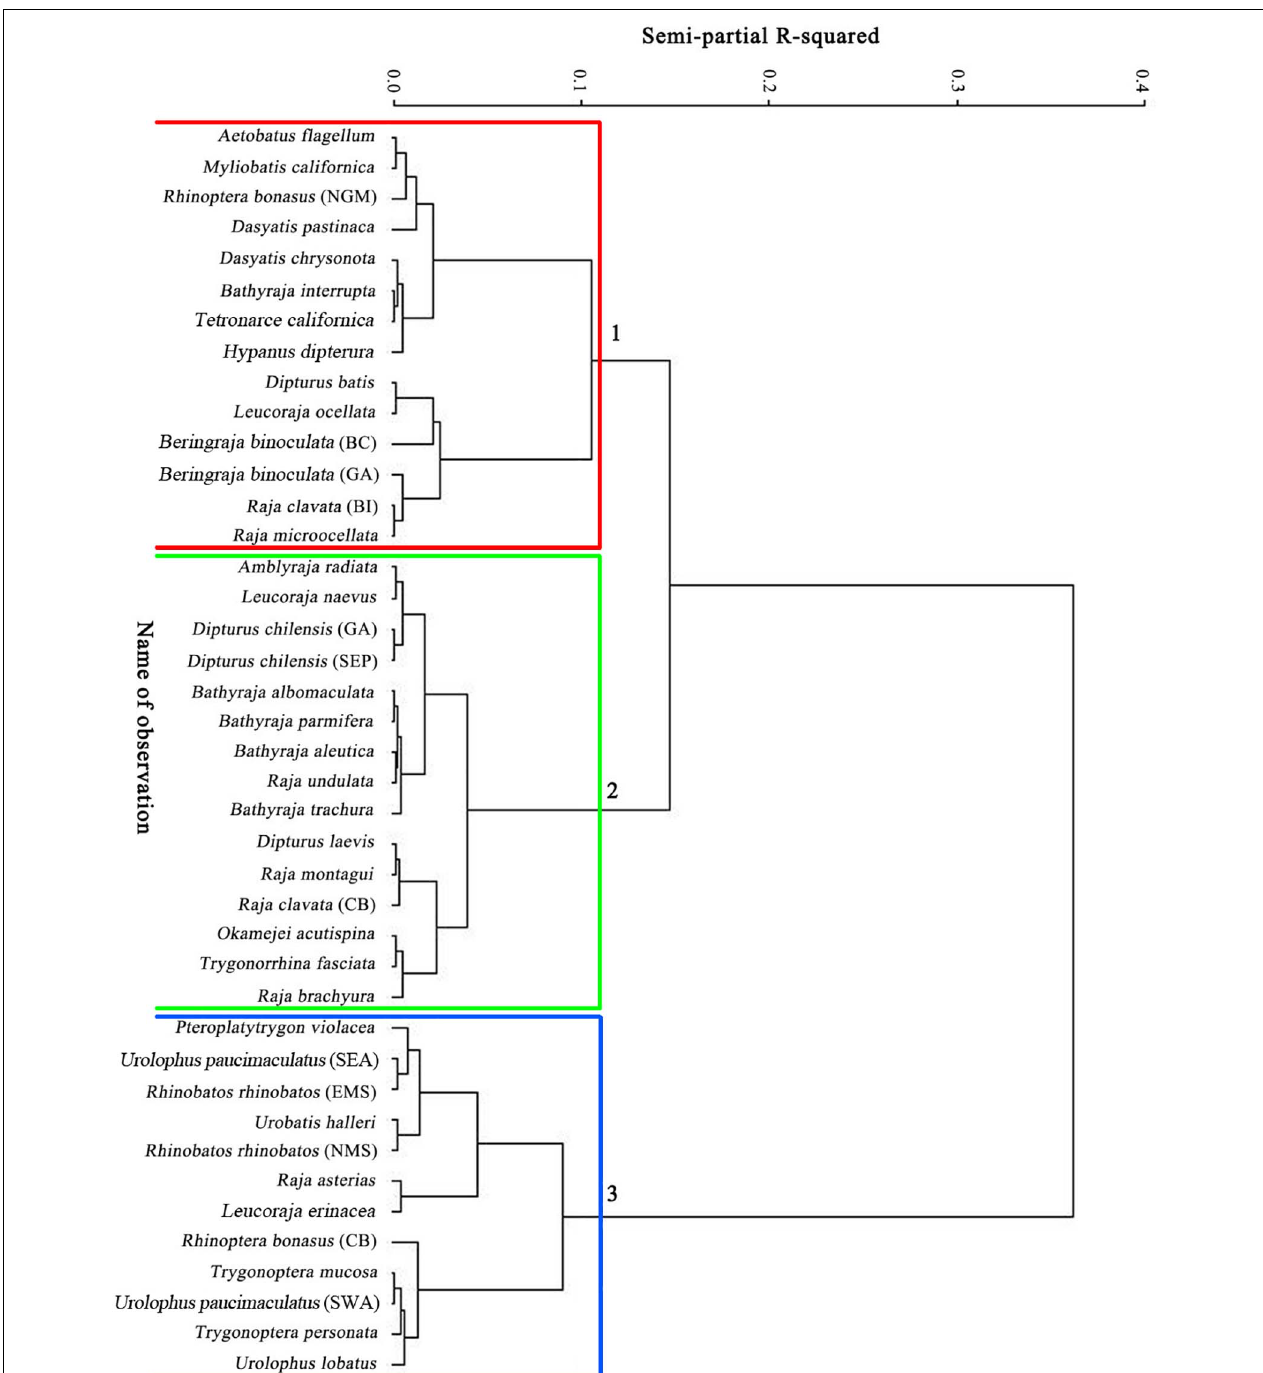
FIGURE 1 | Dendrogram from a cluster analysis of six life history parameters of 41 stocks from 35 species of skates and rays. The grouping shows similarities in life history traits among species and stocks.